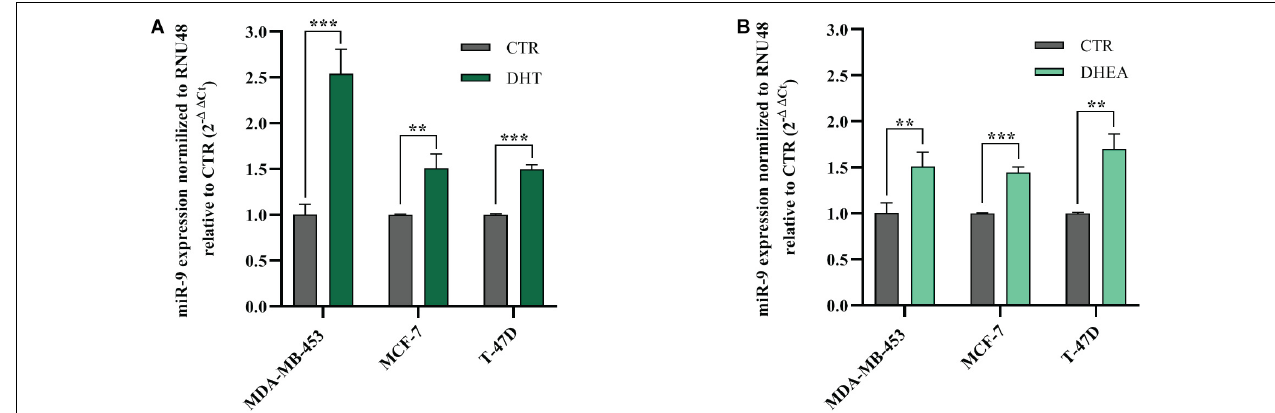
FIGURE 6 | Effects of DHT and DHEA on miR-9-5p (miR-9) expression at 24 h post-transfection (A,B) . ** p < 0.01, *** p < 0.001. Multiple t -test, corrected for multiple comparison using the Holm-Sidak method in (A,B) .